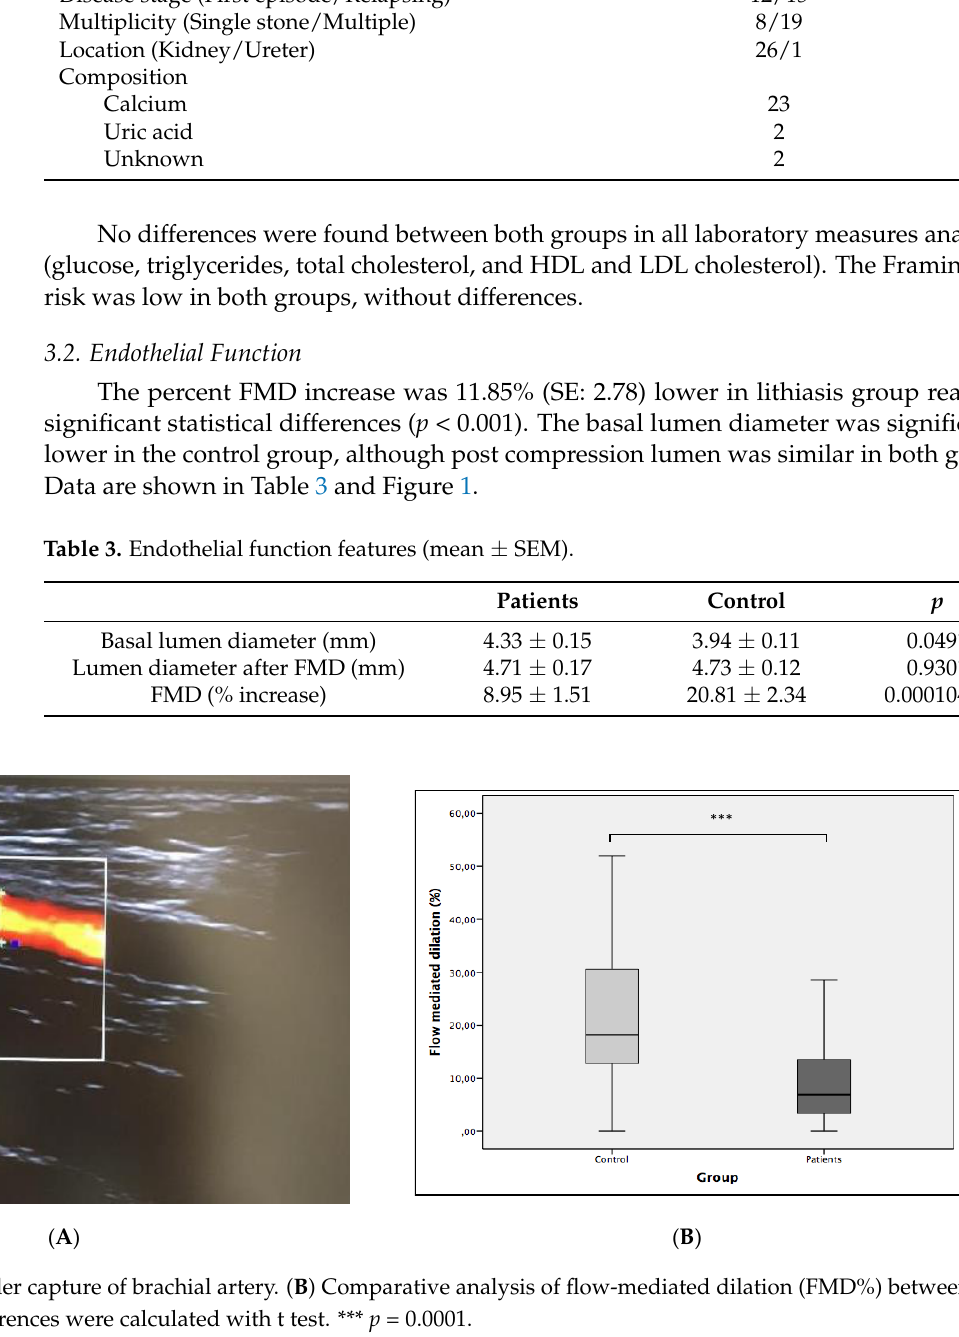
Table 2. Stone characteristics.